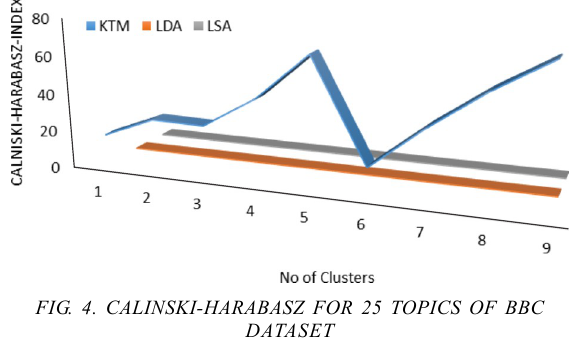
FIG. 4. CALINSKI-HARABASZ FOR 25 TOPICS OF BBC DATASET